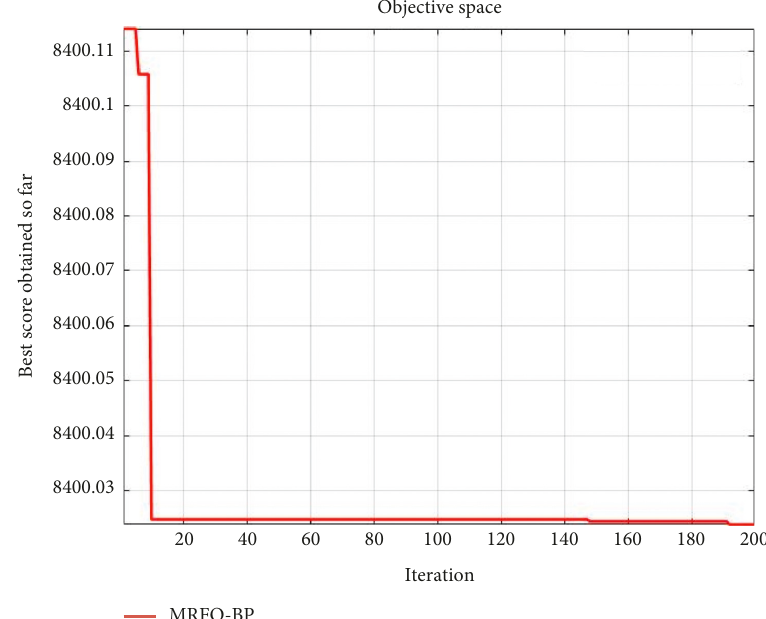
Figure 23: Historical optimal position curve of the outlet (comparative experiment). Table 8: Identification rates of three units based on MRFO-BP neural network (comparative experiment). Measuring point